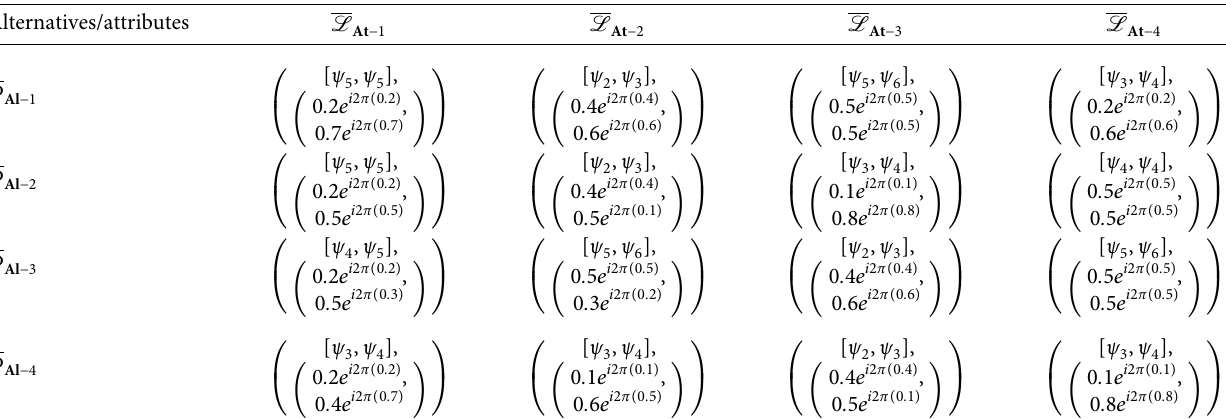
Table 3: Decision matrix in terms of CIULNs provided by expert � R 3